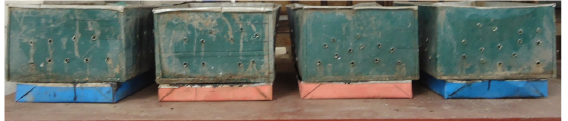
Fig. 2. Aluminium boxes used for production of maggots